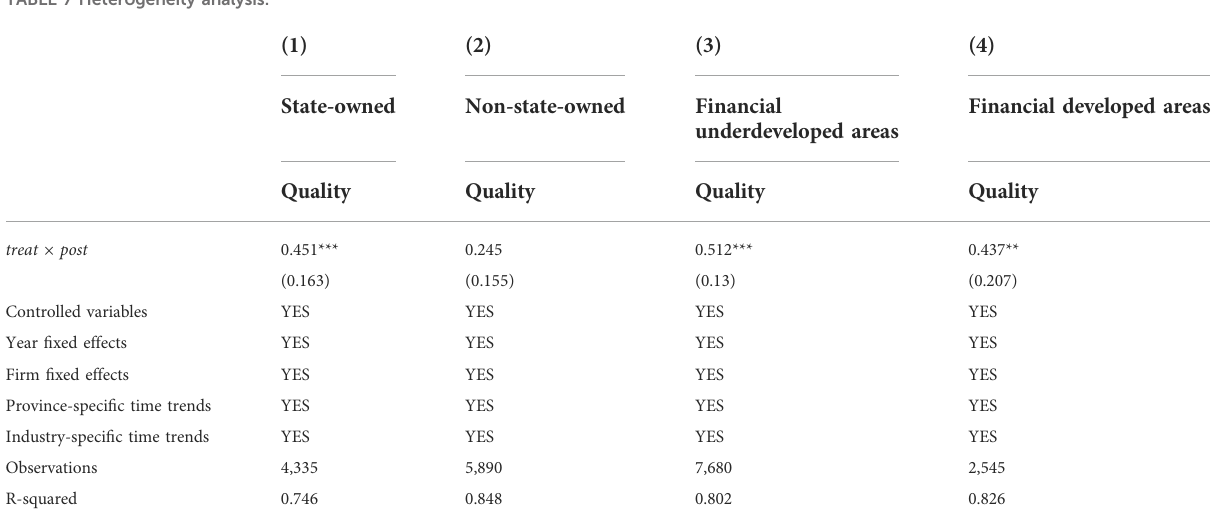
TABLE 7 Heterogeneity